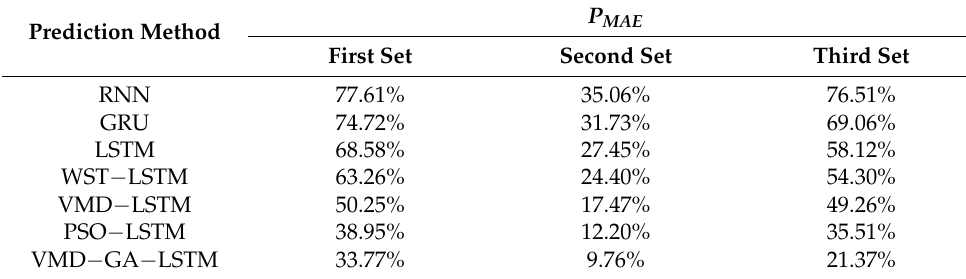
Table 13. P MAE of the VMD − PSO − LSTM method in comparison with the other seven methods. Prediction